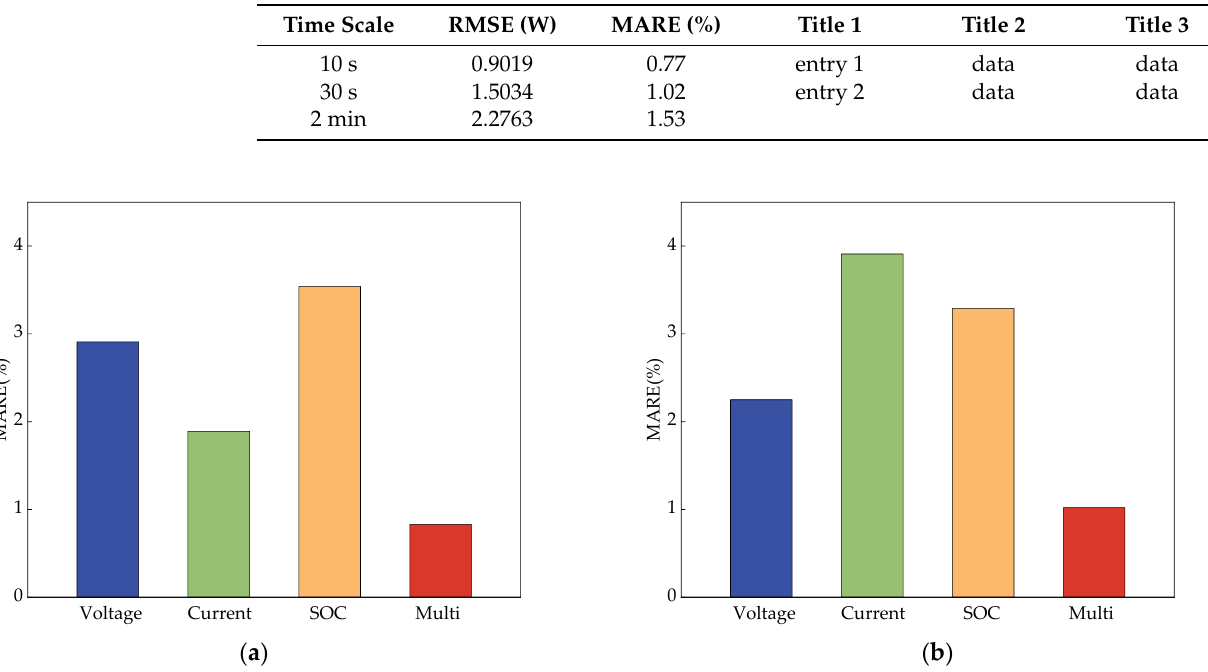
Figure 21. 30 s SOP estimation MARE with different constraints: ( a ) discharge; ( b ) charge.